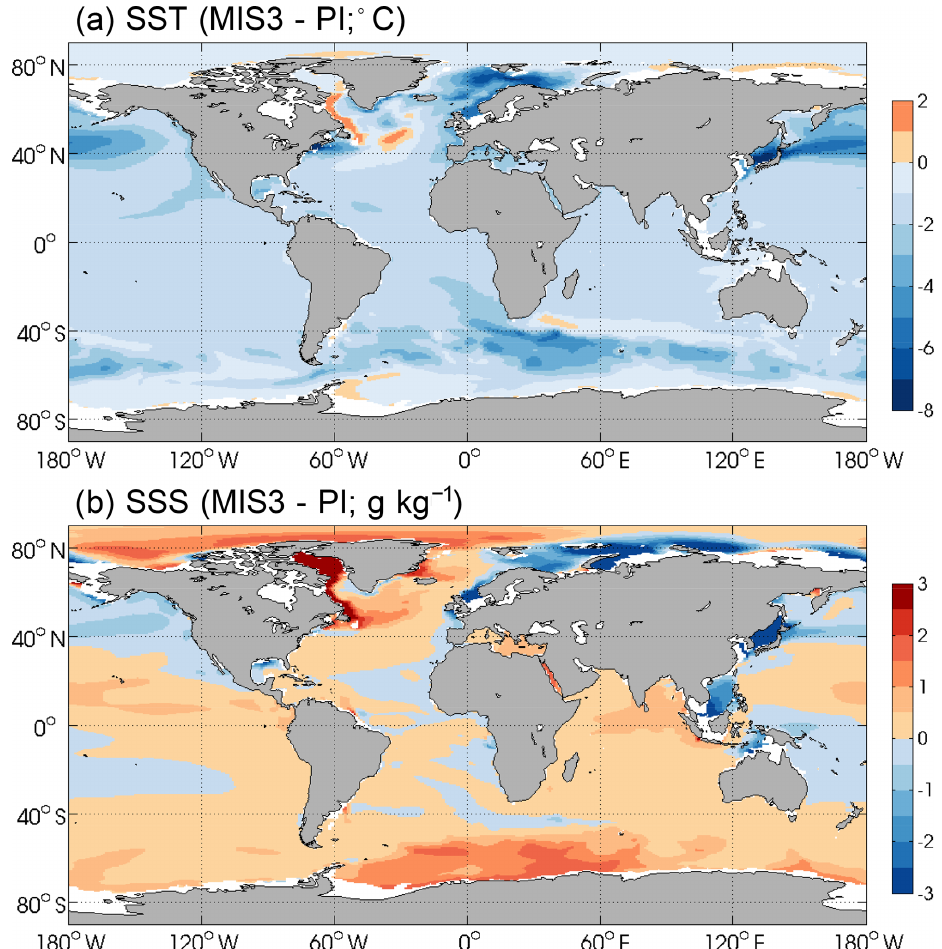
Figure 7. Simulated MIS3 (a) SST and (b) SSS anomalies relative to PI.